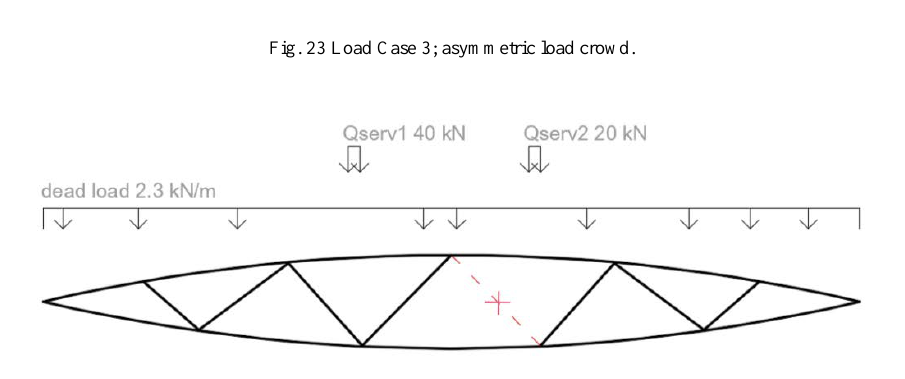
Fig. 24 Load Case 4; vehicle and one diagonal